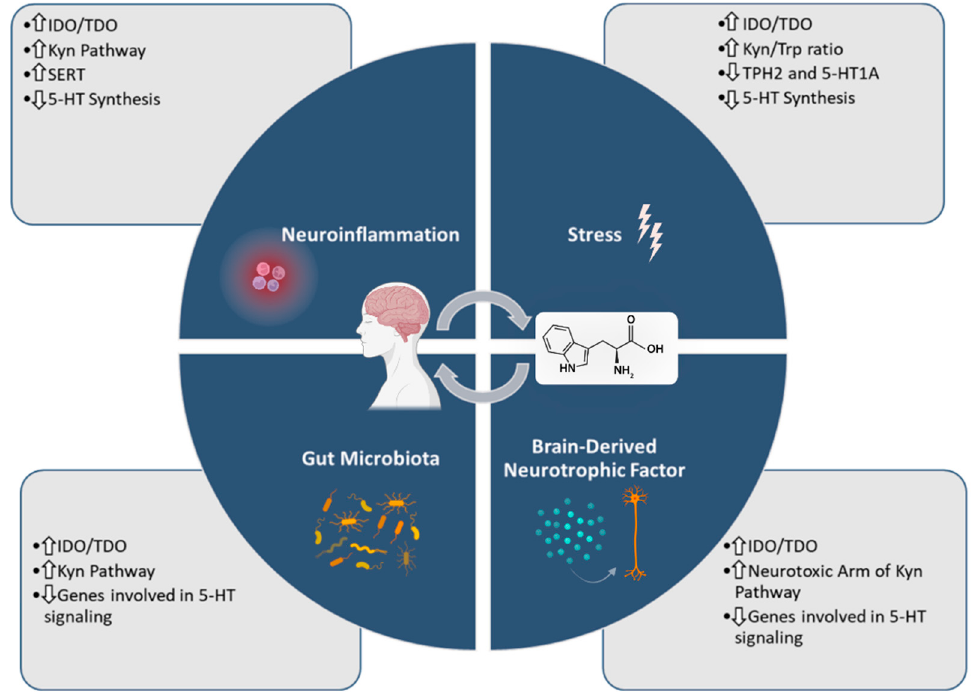
Figure 1. Schematic abstract of the information presented in this review. Briefly, the Trp metabolism is important in several processes connected with depression, particularly neuroinflammation, stress response, gut microbiota dysregulation, and brain-derived neurotrophic factor activity. Illustration created with BioRender [8]. TPH2: tryptophan hydroxylase 2; 5-HT1A: serotonin 1A receptor; IDO: indoleamine 2-3-dioxygenase 1; TDO: tryptophan 2,3-dioxygenase; SERT: serotonin